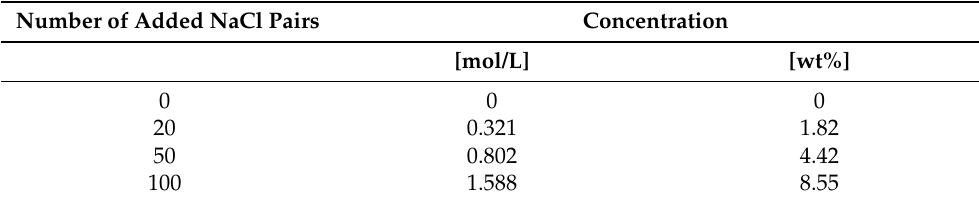
Table 4. Simulation conditions for salt effect investigation.